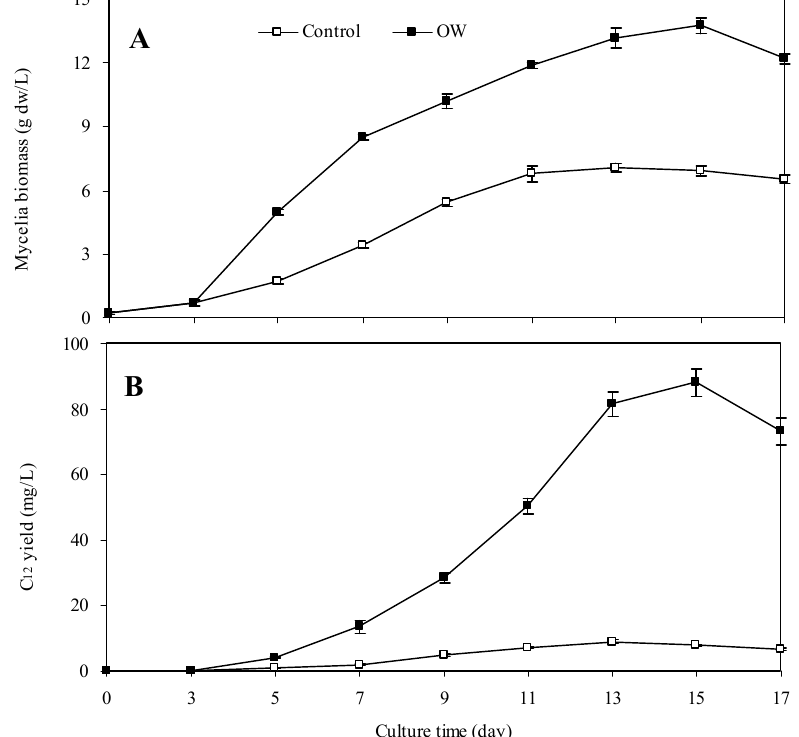
Figure 3. Kinetics of mycelia growth ( A ), palmarumycin C accumulation ( C ), and total sugar content ( D ) after treatment with OW palmarumycin C 13 at 300 mg/L on day 3 in liquid culture of Berkleasmium sp. Dzf12. The period of culture was in 17 days. The error bars represent standard deviations ( n =